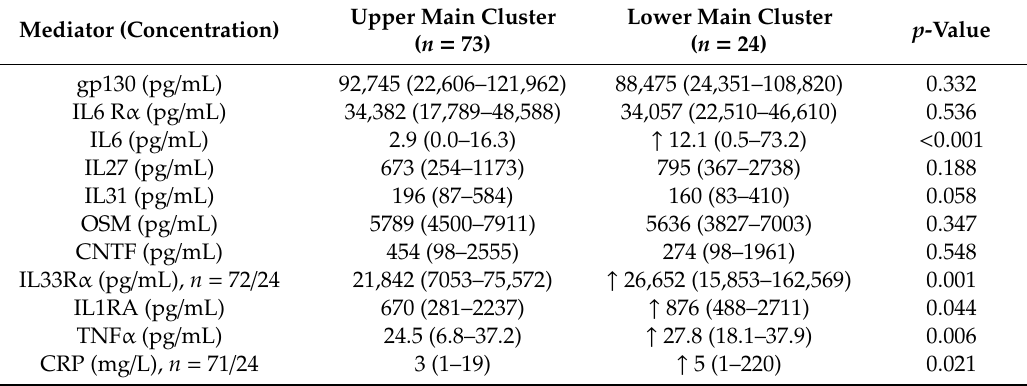
Table 4. The serum mediator levels in patients with renal cancer; a comparison of the two main patient subsets identified in the unsupervised hierarchical cluster analysis based on the seven IL6 family members (gp130, IL6R α , IL6, IL27, IL31, OSM, and CNTF), two IL1 subfamily members (IL1RA and IL33R α ), and TNF α . The results are presented as the median level and variation range. The table presents the levels of the IL6 family members included in the clustering analysis together with the levels of IL1RA, IL33R α , TNF α , and